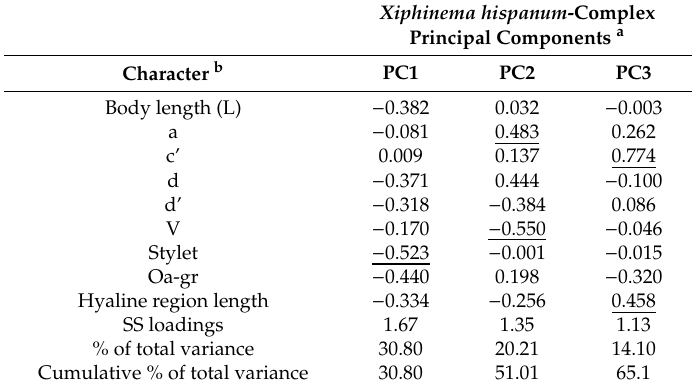
Table 2. Eigenvectors and SS loadings of factors derived from nematode morphometric characters